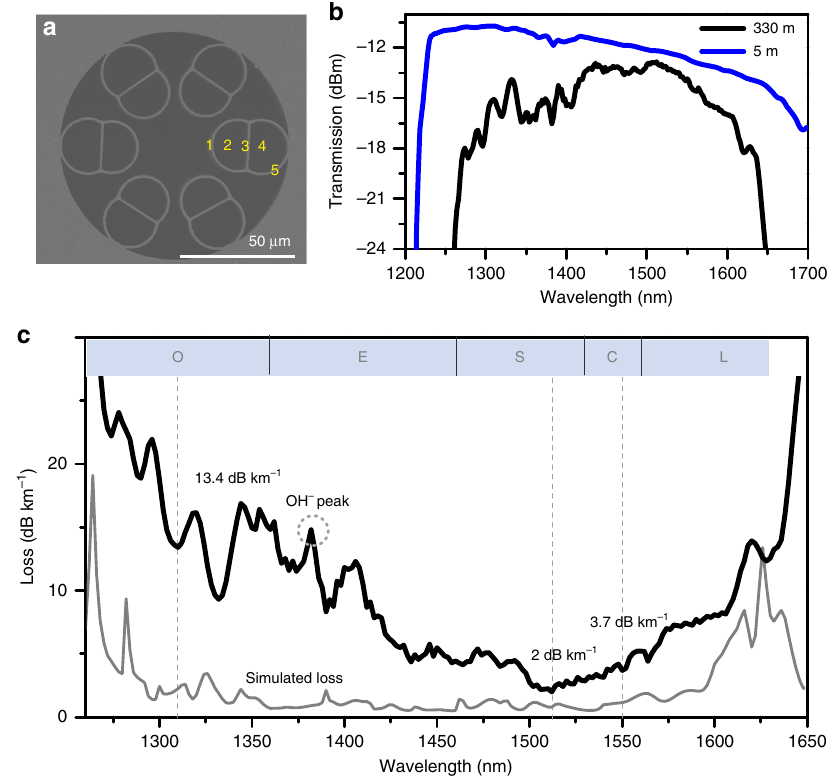
Fig. 1 Demonstration of an ultralow-loss broadband CTF. a Scanning electron microscope (SEM) image of the fabricated CTF with outer diameter of 295 µ m. The yellow numbers label the fi ve dielectric layers in the cladding. b Measured transmission spectra of the 330 m (black) and 5 m (blue) long CTF under the same launching condition. c Measured cut-back loss (black) and simulated loss (grey, including both CL and SSL). The spectral extension of the optical telecommunication O, E, S, C and L bands are also shown for comparison